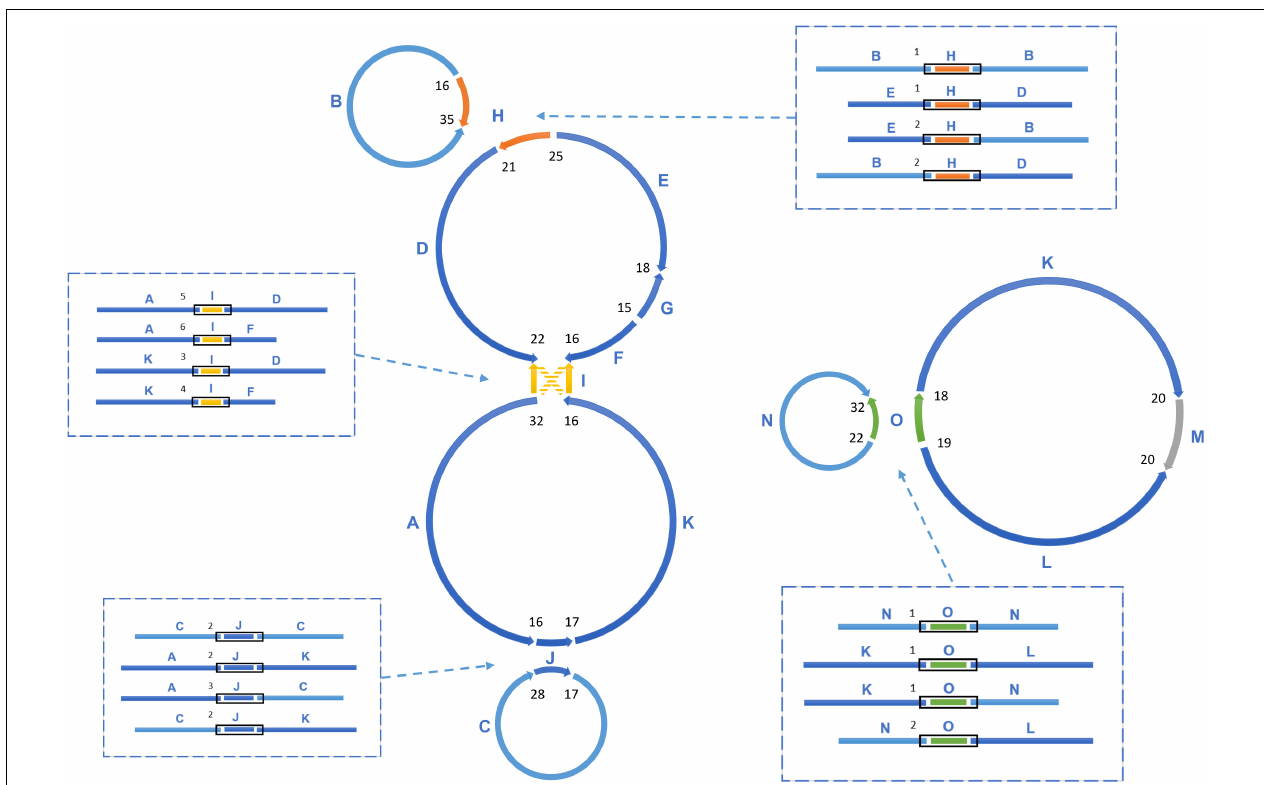
FIGURE 2 | The assembly graph of multipartite T. esculentum mitochondrial genome. The marama mitochondrial genome is composed of 5 circular molecules, which were built based on 16 primary long scaffolds. 4 of them shown here including H, I, J, O are long repeats, which are present in two copies in the marama mitogenome. The scaffolds are assembled together by the PacBio long reads across the gaps. Connections between two adjacent scaffolds were quantified by PacBio reads and the counts are shown as numbers in black. Recombination on repeats causes the existence of different connections between the same scaffolds, which are shown (within black boxes) in the dashed boxes and also quantified by PacBio reads. The numbers next to the black boxes represent their counts. According to the connections shown in the dashed boxes, the 16 scaffolds can also be assembled into two long rings, as shown in Figure 3 . The PacBio long reads data confirmed that these two structures co-exist in the experimental individual and they are close to the same frequency.